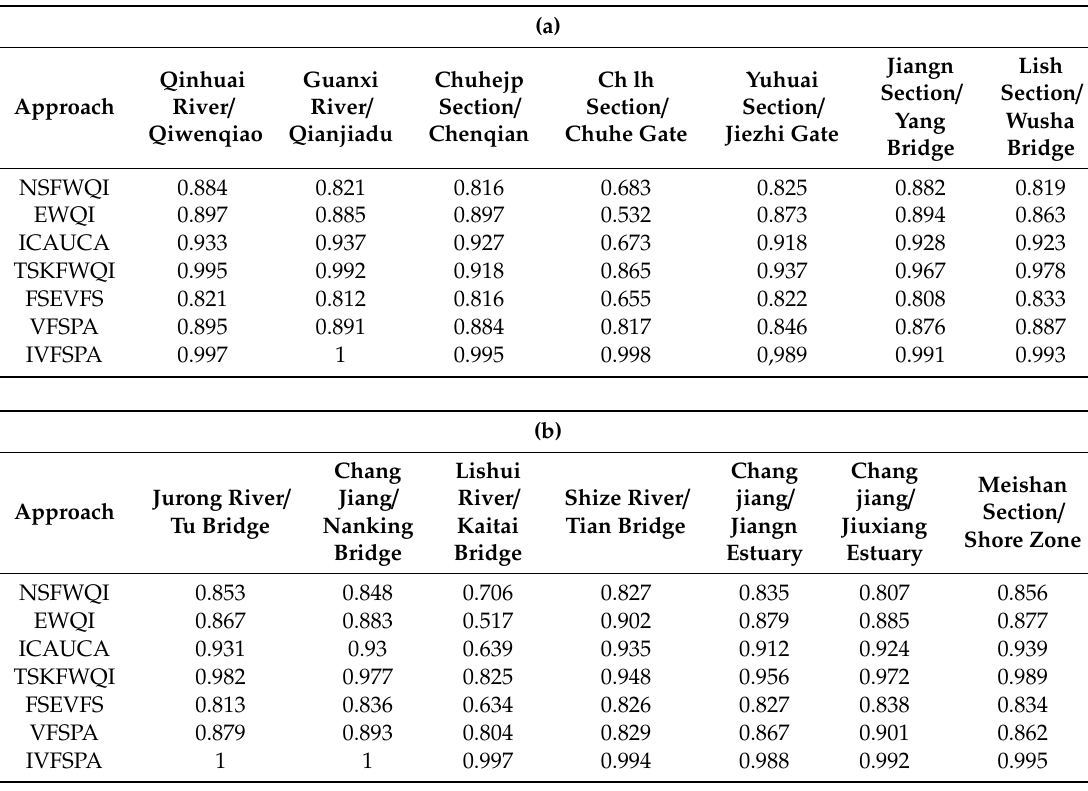
Table 7. ( a ) Experimental detailed results of precision. ( b ) Experimental detailed results of precision.